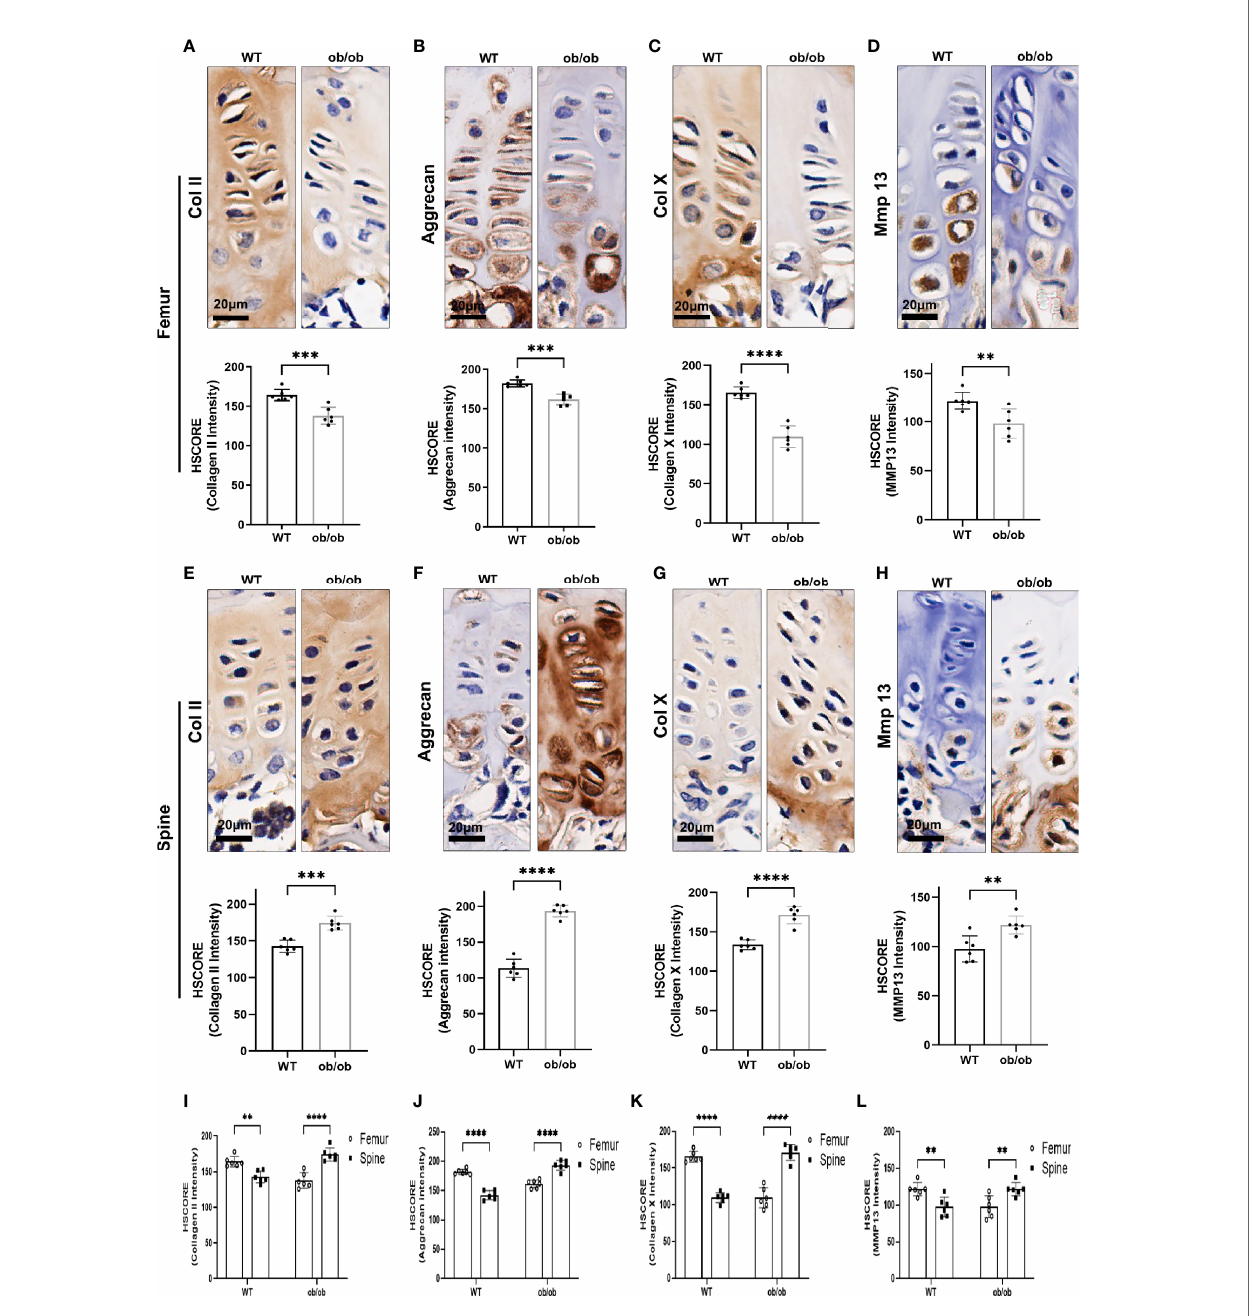
FIGURE 4 | Comparison of femur and vertebral growth plate chondrocyte proliferation and hypertrophic markers between wild-type (WT) mice and ob/ob mice using immunohistochemistry (IHC) staining method, including collagen II (A, E) , aggrecan (B, F) , Col X (C, G) , and MMP13 (D, H) . Comparison of HSCORE of proliferation and hypertrophic markers between femur and vertebral growth plate in WT or ob/ob mice (I – L) . Scale bar: 20 m m; n = 6 in each group, ** p < 0.01, *** p < 0.001, and **** p < 0.0001; ns denotes not signi fi